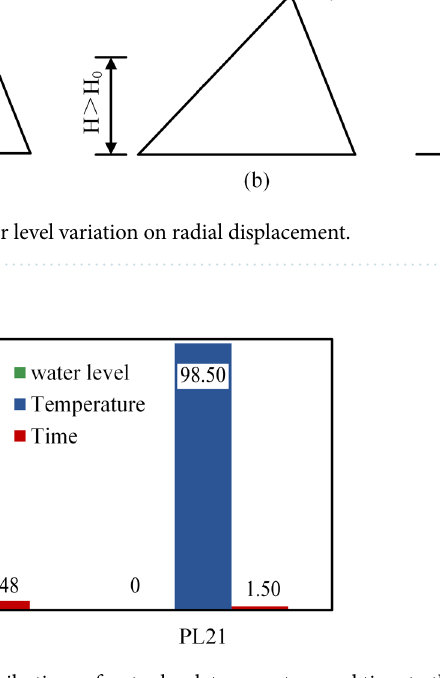
Figure 18. The average contributions of water level, temperature and time to the tangential